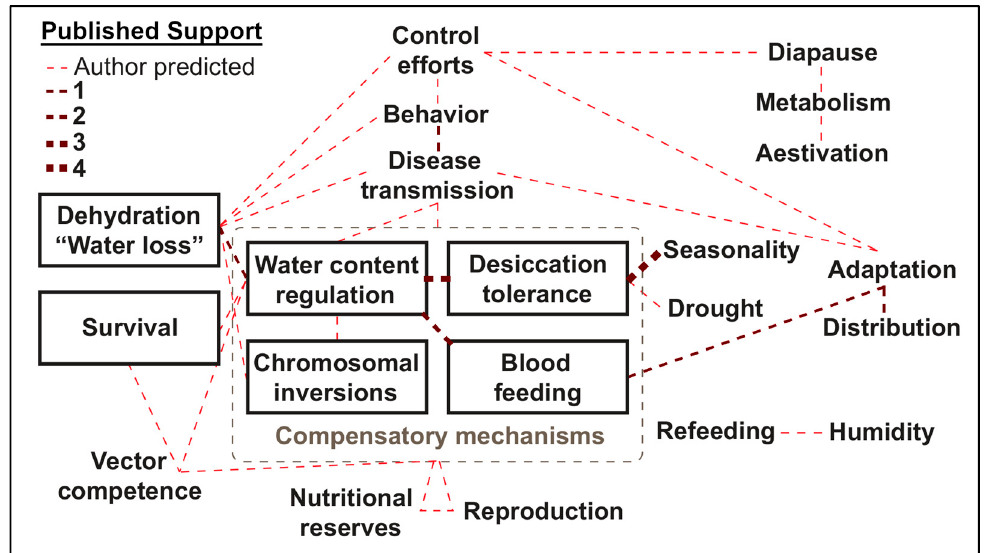
Figure 2. Predicted associations related to the dehydration of mosquitoes as proposed throughout the review. Red dashed lines represent associations solely predicted in this publication (“Author predicted”), blood red dashed lines are author predictions supported by other publications, and the number of supporting publications is represented by line thickness (1–4). Proposed compensatory mechanisms are grouped inside a dashed grey box. All terms and relationships are outlined in Table S3.